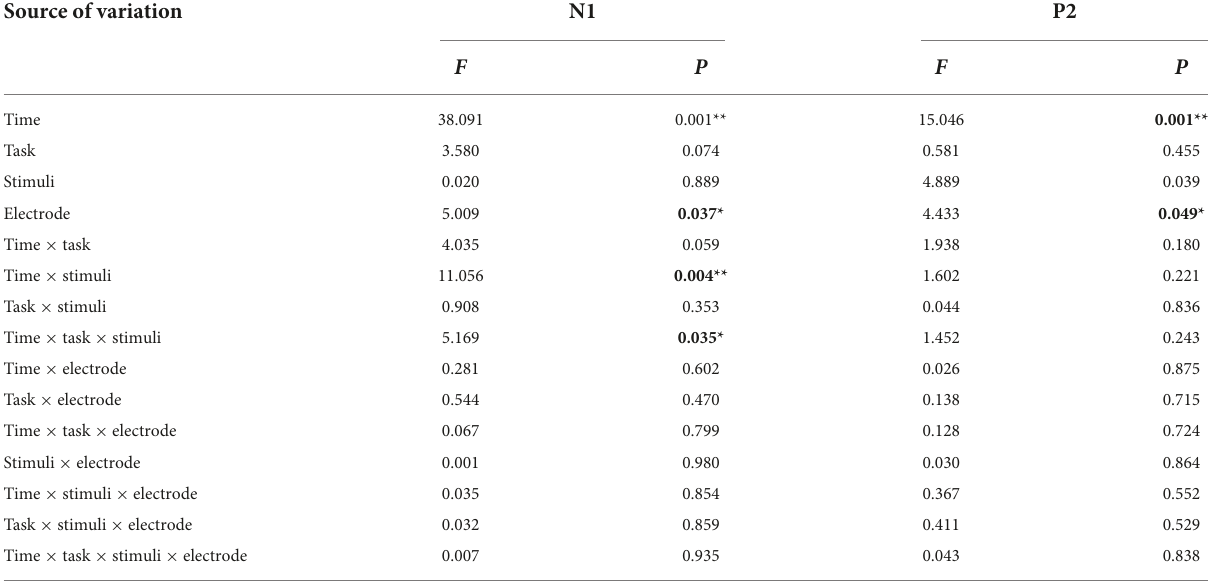
TABLE 5 Statistical analysis for N1, P2 before and after chemotherapy. Source of